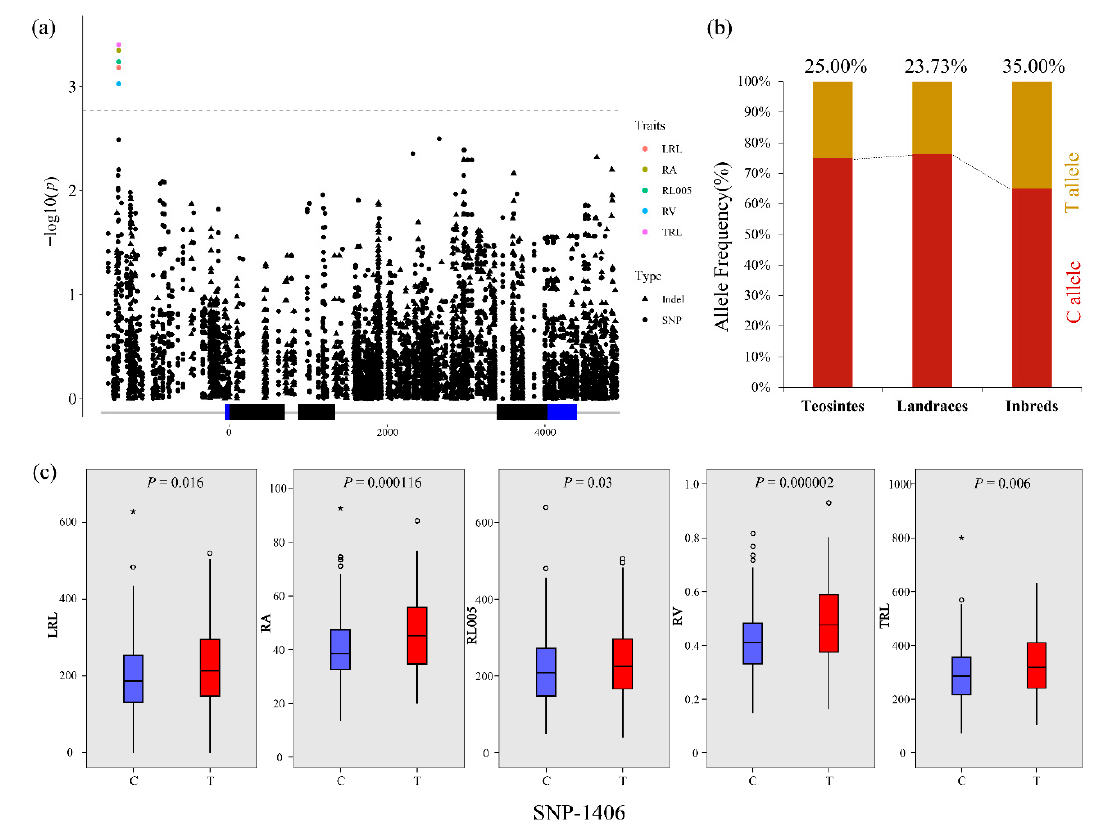
Figure 4. The natural variation of ZmCKX5 was significantly associated with lateral root length (LRL), total root area (RA), root length in 0 to 0.5 mm diameter class (RL005), total root volume (RV), and total root length (TRL); ( a ) Trait–marker association between ZmCKX5 and root traits; ( b ) The allele frequency of SNP-1406 in teosintes, landrace, and inbred lines; ( c ) Comparison of LRL, RA, RL005, RV, and TRL between different alleles of SNP-1406. * indicated an individual with extreme value.